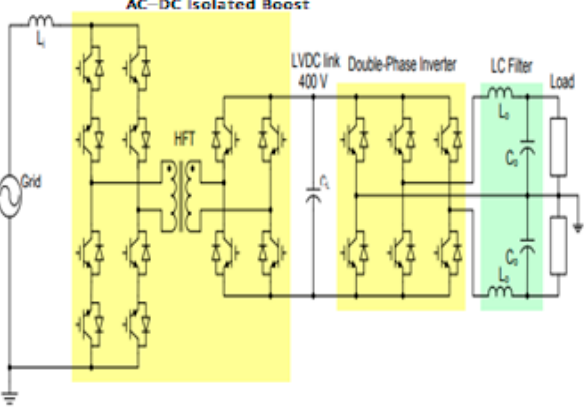
Figure 11. Two-stage SST based on an AC–DC Isolated Boost converter [71]. Reprinted with permis- sion from Ref. [71]. 2022, IEEE.